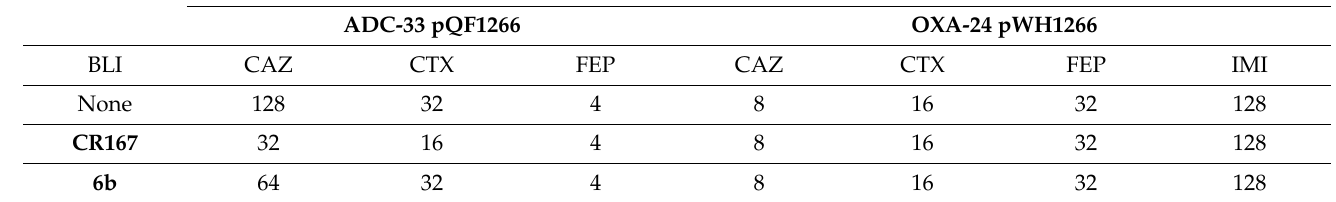
Table 4. Antimicrobial susceptibility testing results for A. baumannii isolates containing cloned ADC-33 and OXA-24/-40 using broth microdilution. The inhibitors CR167 and 6b were used at 10 mg/L.